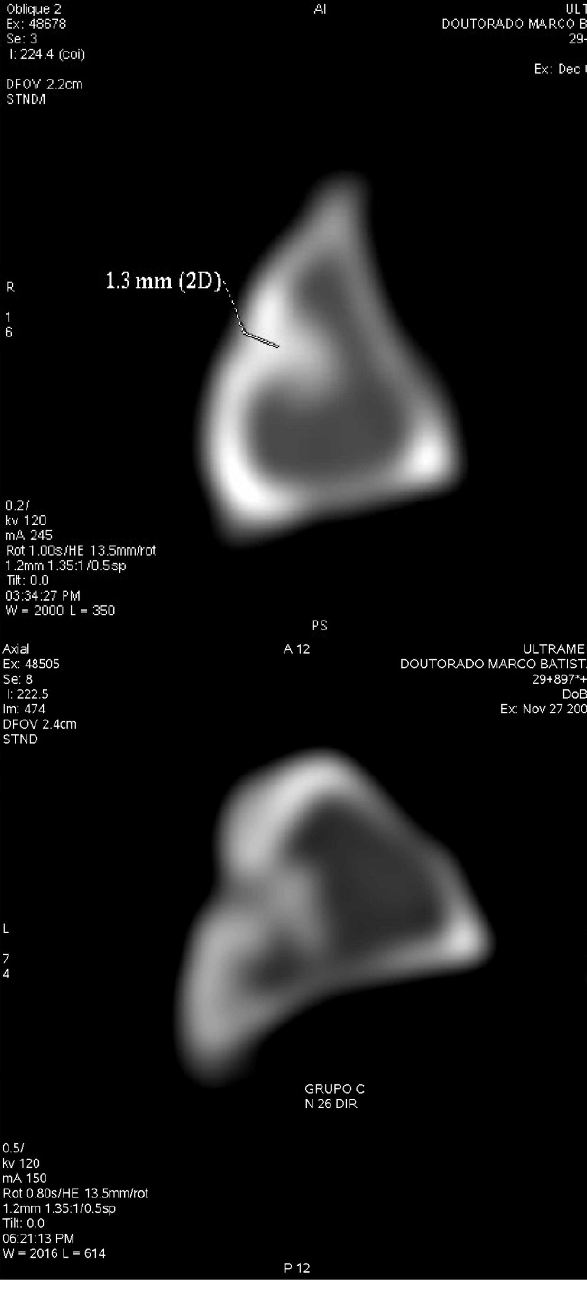
Figure 2 - Axial CT image of the tibia of an animal in the PRP group showing the consolidation of newly formed bone defect and a cortical thickness of 1.3 mm (a) and the BMC group showing no consolidation of the cortical bone defect (b).